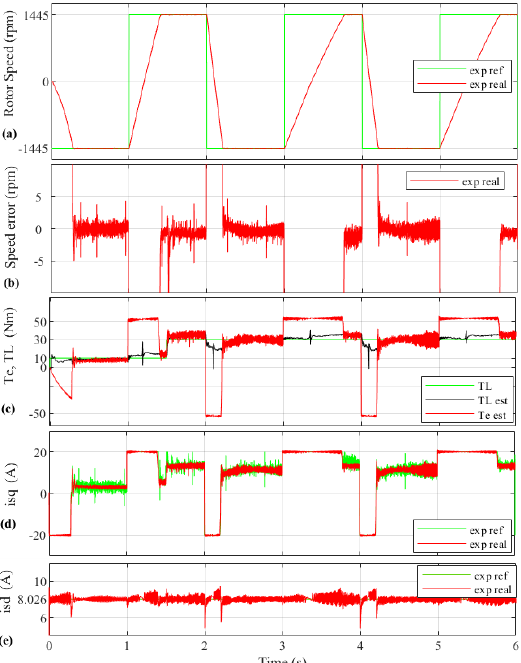
Figure 5. Experimental results by using 1445 rpm reference speed and two load torque step changes (D2 design): ( a ) Rotor speed; ( b ) Speed error; ( c ) T e , T L ; ( d ) Torque current and ( e ) Rotor flux current.